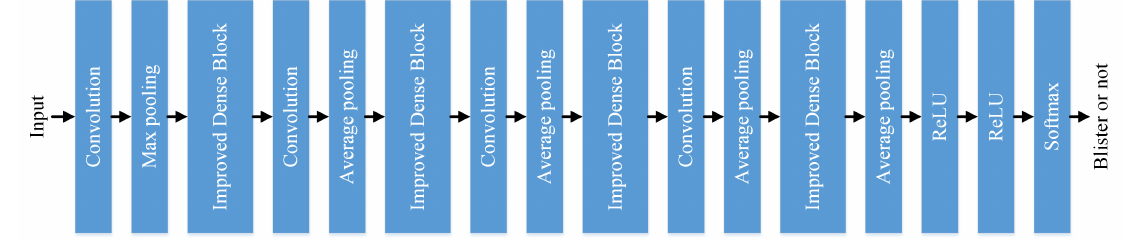
Figure 5. Proposed CNN architecture for blister